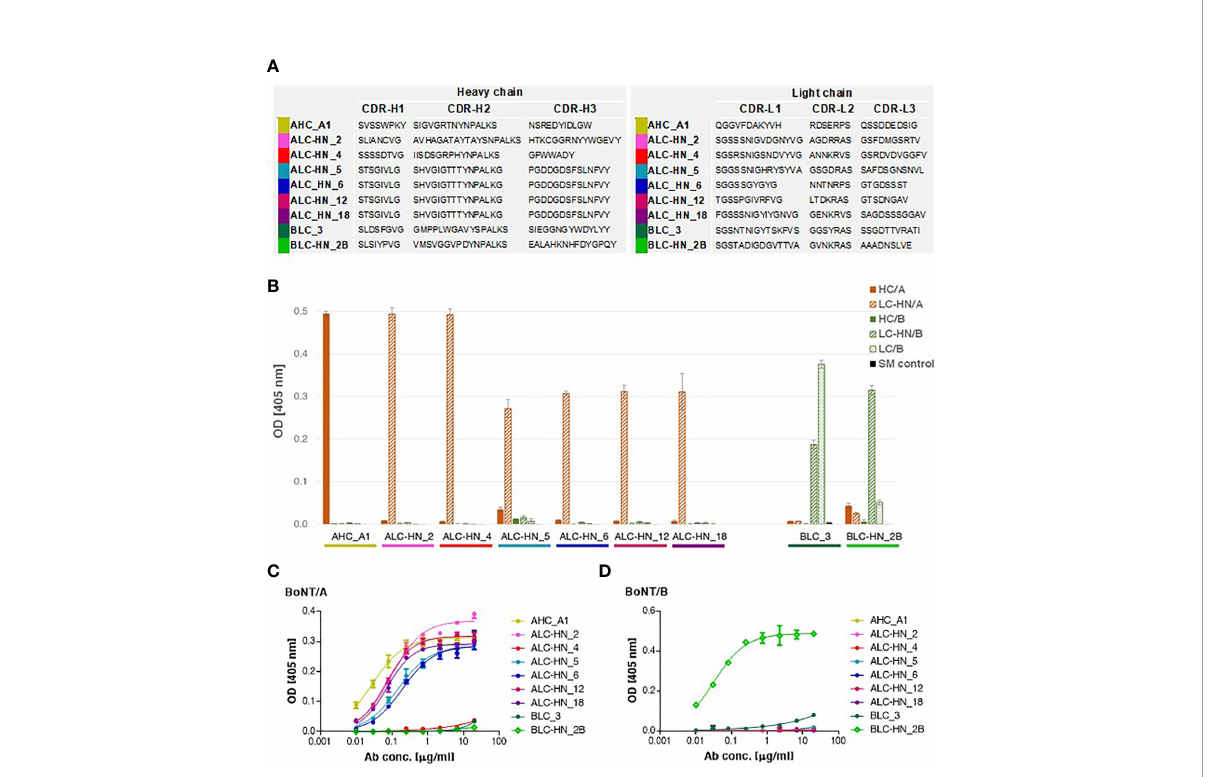
FIGURE 3 Characterization of the anti-BoNT Centaur mAbs. (A) Amino acid sequences of the VH and VL CDR segments of the anti-BoNT selected mAbs. CDR positions are indicated according to the Kabat system (36). (B) Speci fi city of the nine selected mAbs determined by ELISA against the indicated BoNT subunits. Data represent average of triplicates ± SD. Skim milk (SM) was used as control protein, as indicated in the in-set legend. (C, D) Binding ability of the selected mAbs was evaluated against BoNT native toxins. Each indicated mAb was serially diluted and tested in duplicates by indirect ELISA against BoNT/A (C) and BoNT/B (D) . Data represent average ±